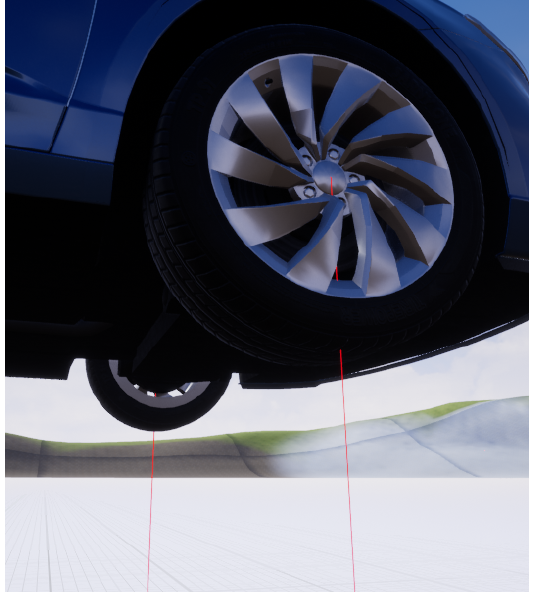
Figure 4. Wheels raycast curb